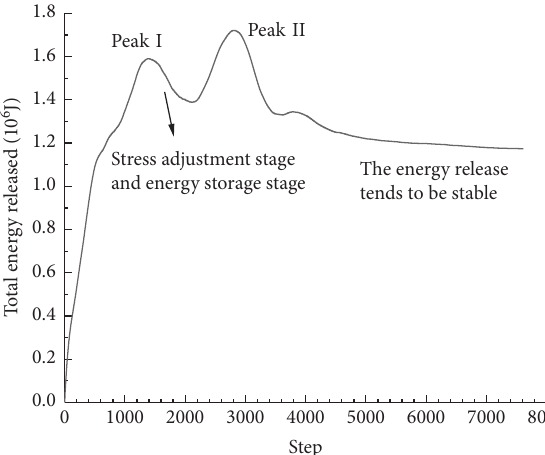
Figure 10: Curve of the total energy released from surrounding